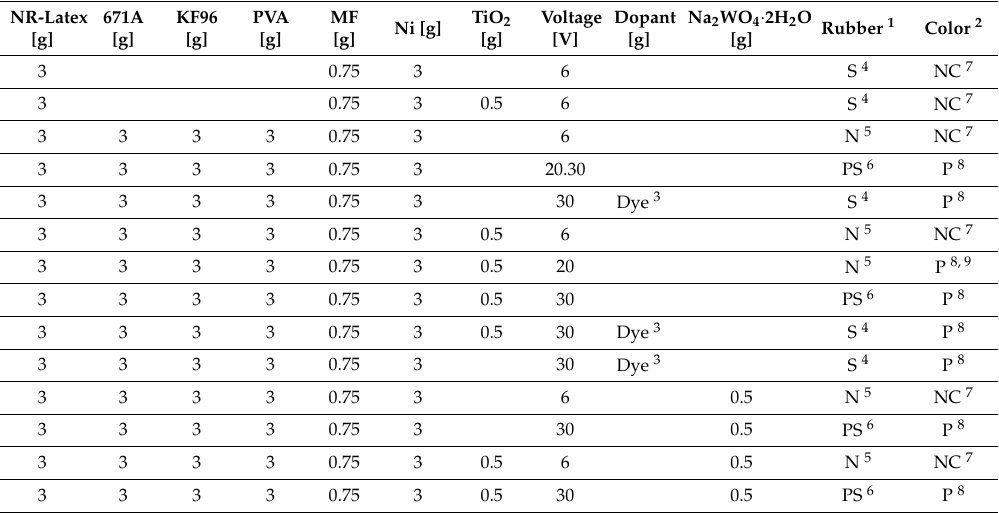
Table 2. Results of solidification by electrolytic polymerization and color of anode after the electrolytic polymerization in the case of titanium anode.